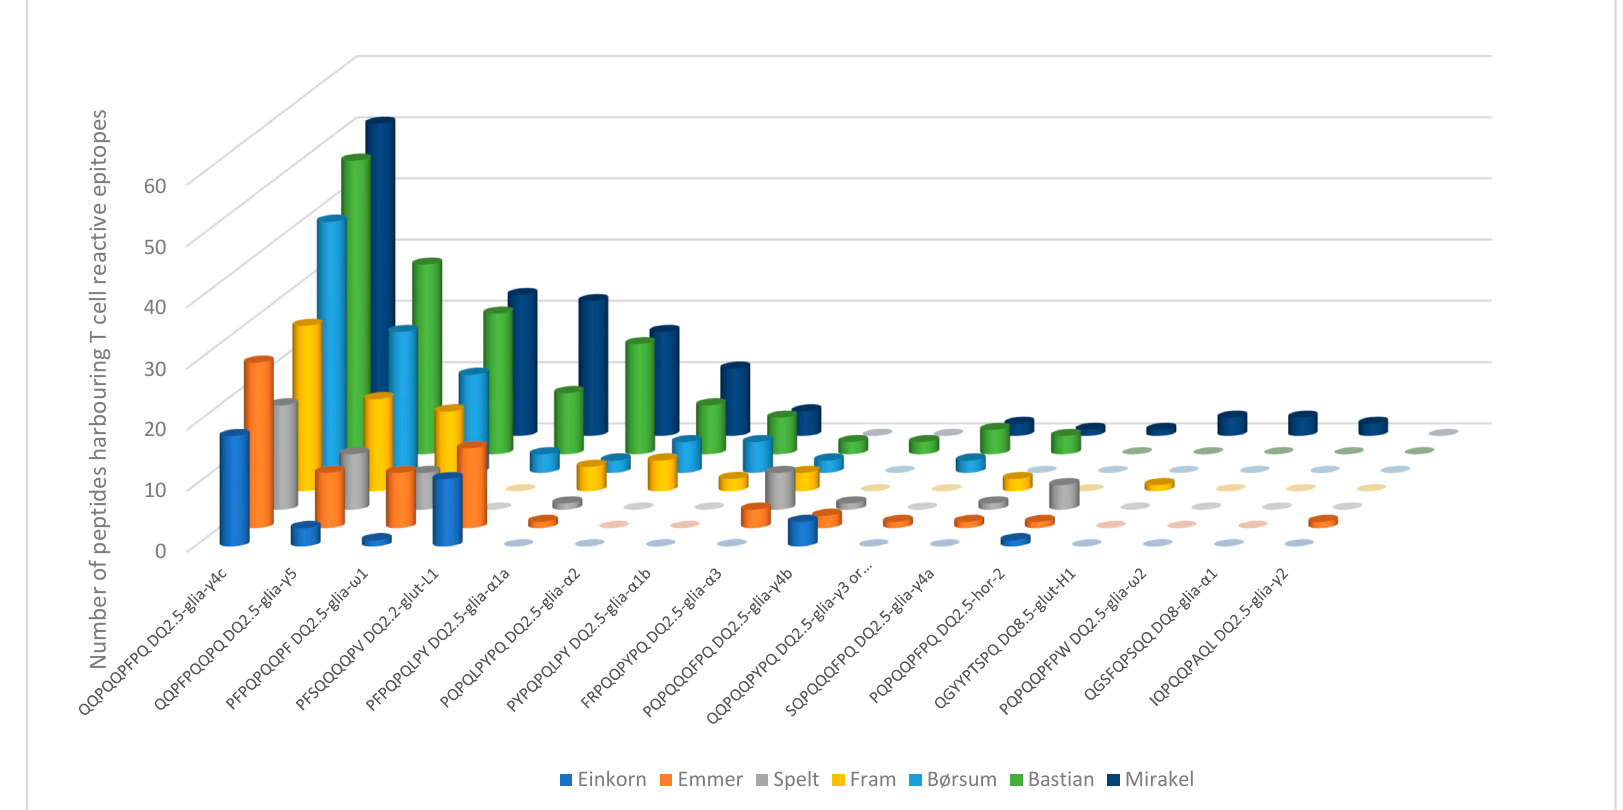
Figure 3. Graphical representation of the number of peptides with the indicated T cell epitope in each wheat type represented by different colors. The number of epitopes is retrieved by counting the given epitope sequences in the assorted peptide list. Each bar represents a naïve T cell epitope sequence, e.g., the PFPQPQLPY sequence is specific to the DQ2.5-glia- α 1a epitope [19]. Abbreviations are used to denote which gliadin fraction the epitopes are derived from: glia- α , α -gliadin; glia- γ , γ -gliadin; glia- ω , ω -gliadin; glut-L, low molecular weight glutenin; glut-H, high molecular weight glutenin; hor, hordein.